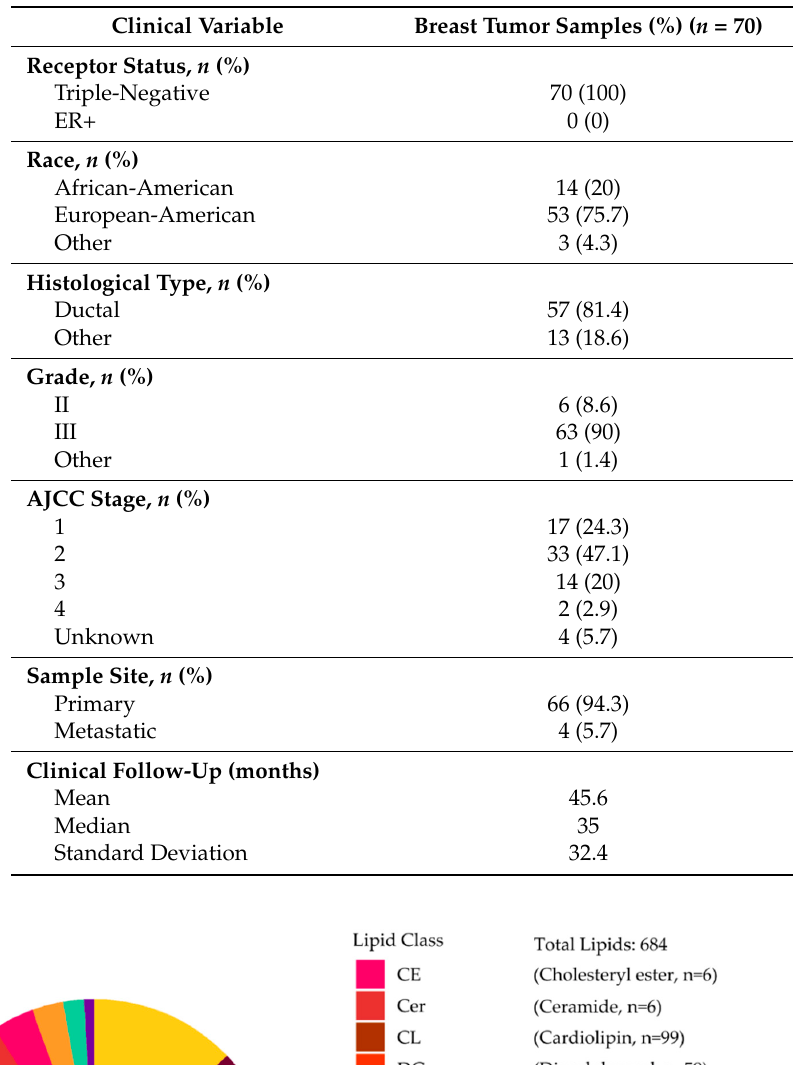
Table 1. Clinical parameters of breast tumor samples.